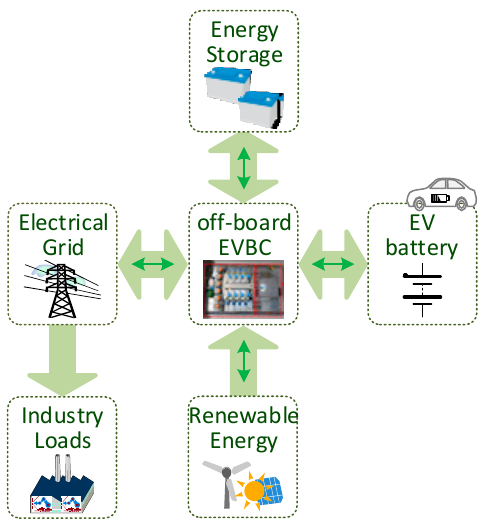
Figure 19. Off-board EVBC: Unified operation of power quality compensator, renewables and energy storage systems.